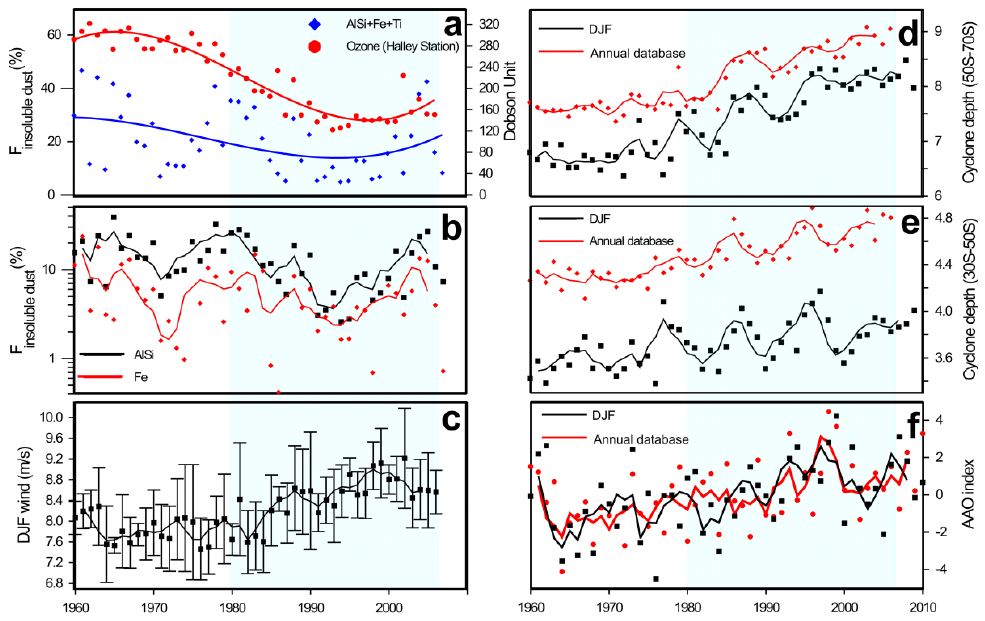
Fig. 1. (a) Fraction of insoluble dust microparticles (AlSi + Fe + Ti) at Mount Johns and ozone concentrations measured for October at Halley Bay Antarctic Stations (both with polynomial trends of degree 3 overlaid); (b) fraction of insoluble dust microparticles for AlSi and Fe, individually; (c) DJF wind intensity for 40–70 ◦ S (error bar: 1 standard deviation); (d) cyclone depth for DJF and the annual databases for the latitudinal bands 50–70 ◦ S and, (e) the same for 30–50 ◦ S; and (f) for AAO index. Shaded areas highlight the period of depleted ozone